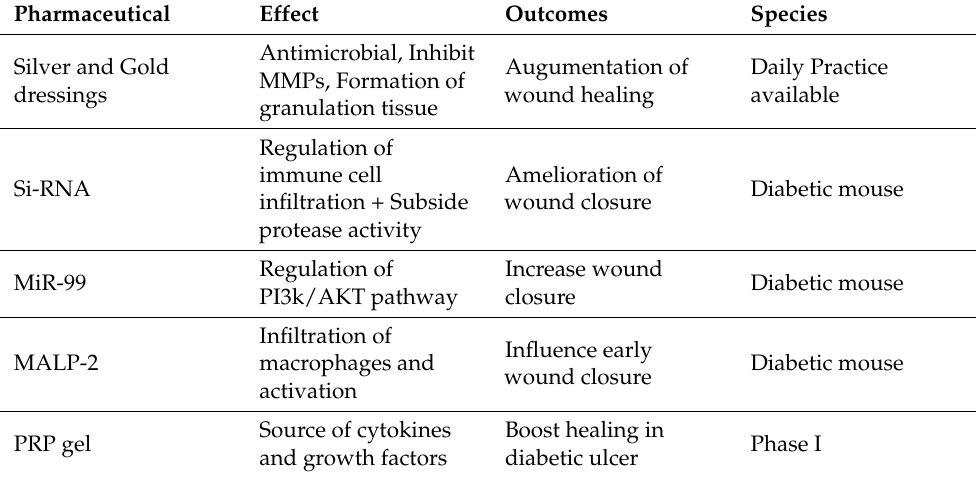
Table 1. Biomaterial-based immunomodulators, reproduced from Wright JB, Lam K, Buret AG, Olson ME, Burrell RE. Early healing events in a porcine model of contaminated wounds: effects of nanocrystalline silver on matrix metalloproteinases, cell apoptosis, and healing. Wound Repair Regen 2002; 10:141–151.) and Forlee M, Rossington A, Searle R. A prospective, open, multicenter study to evaluate a new gelling fiber dressing containing silver in the management of venous leg ulcers.